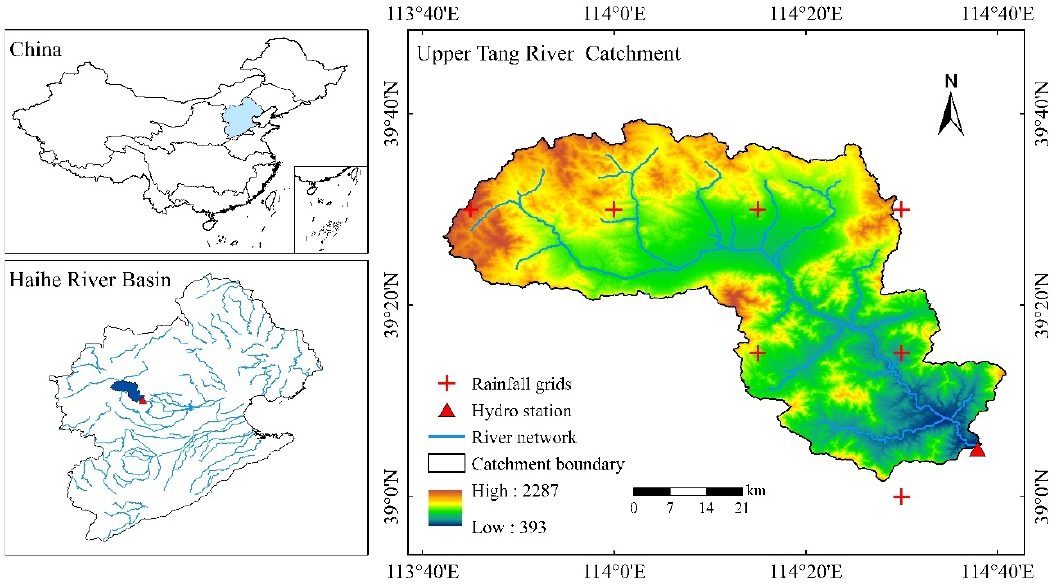
Figure 1. The terrain, river network, and geographical location of the hydrometric station in the upper Tang River catchment.